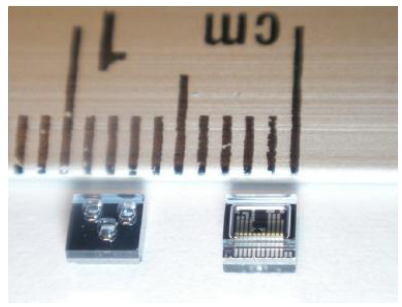
Figure 15. Picture of fabricated